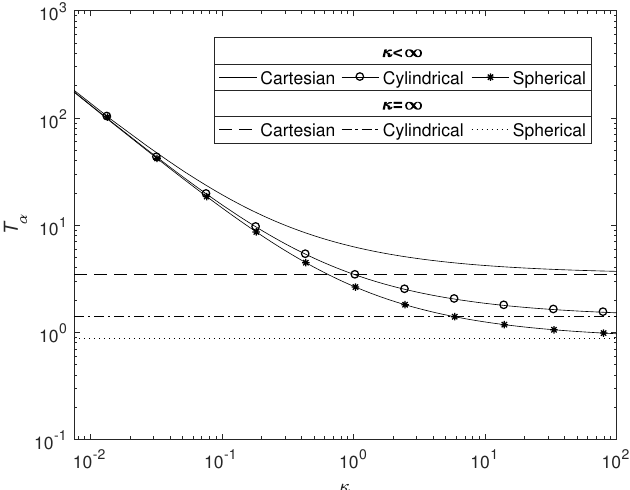
Figure 8. Plots of the dimensionsionless T α against κ for the three principle geometries, with ε 1 = 0.6 ε 2 = 0.4, S 0 = 1 and the parameters listed in Table